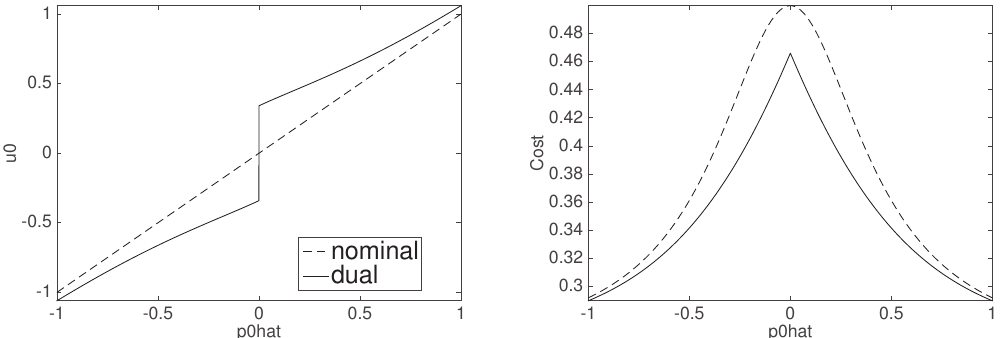
Figure 4. The left graph illustrates the nominal and optimal experimental design performance on the proposed example. The displayed cost is calculated according to the cost proposed in (24), which (cid:105) (cid:104) 1 − e )) 2 ( u − ( ˆ p − e )) 2 + 1 ( u ∗ ) − ( ˆ p ( ˆ p in this example. The right graph displays reads as E e 0 0 0 0 0 1 1 2 2 the corresponding inputs. Observe that the right-hand graph ought to be compared to the right-hand graph of Figure